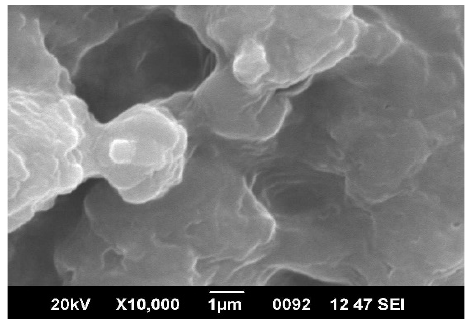
Figure 2. SEM images of nanoparticles of Silver.